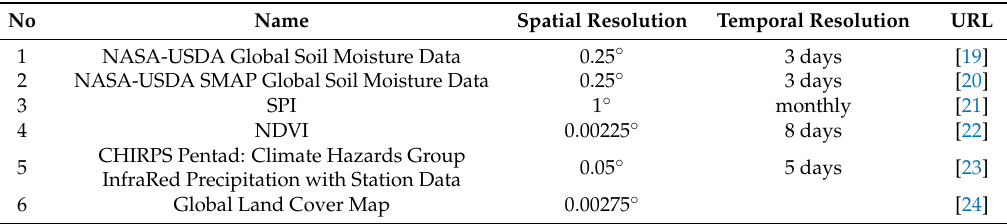
CHIRPS Pentad: Climate Hazards Group InfraRed Precipitation with Station